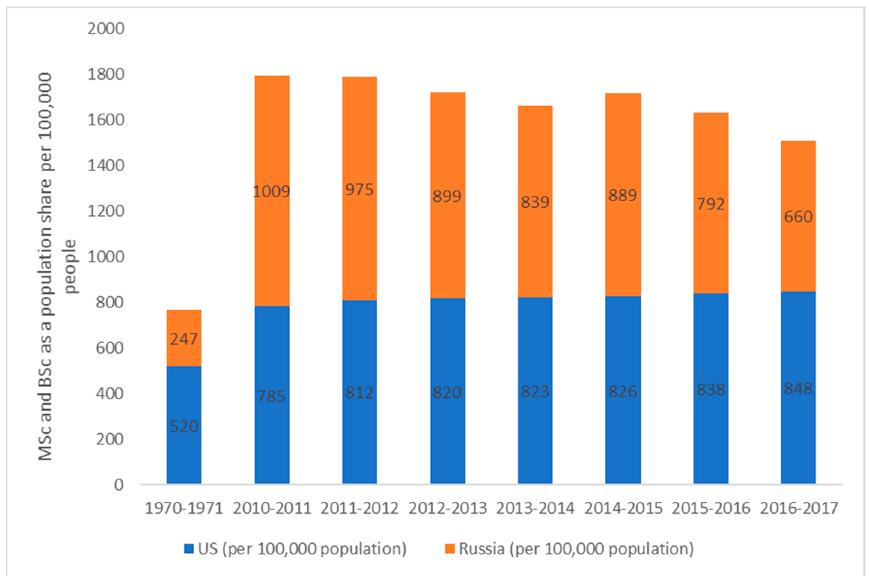
Figure 2. Number of students per 100,000 people in the United States and Russia. Source: Own results based on the U.S. Department of Education (2018) and Federal State Statistics Service of the